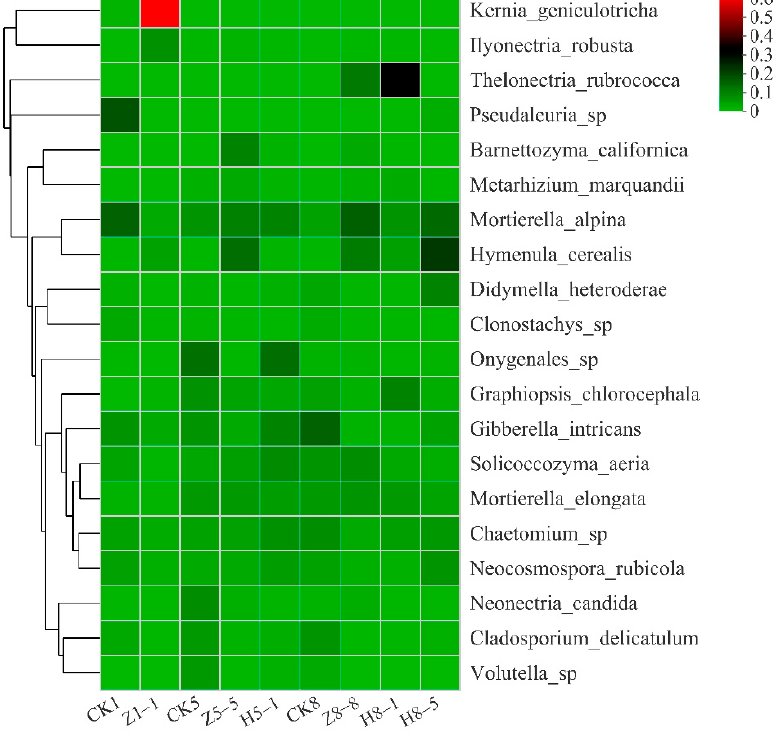
Figure 6. Heat map of fungi species with top 20 relative abundances in the soil in different years of growing and replanting. Note: The nomenclature for each sample is the same as that in Table 2.